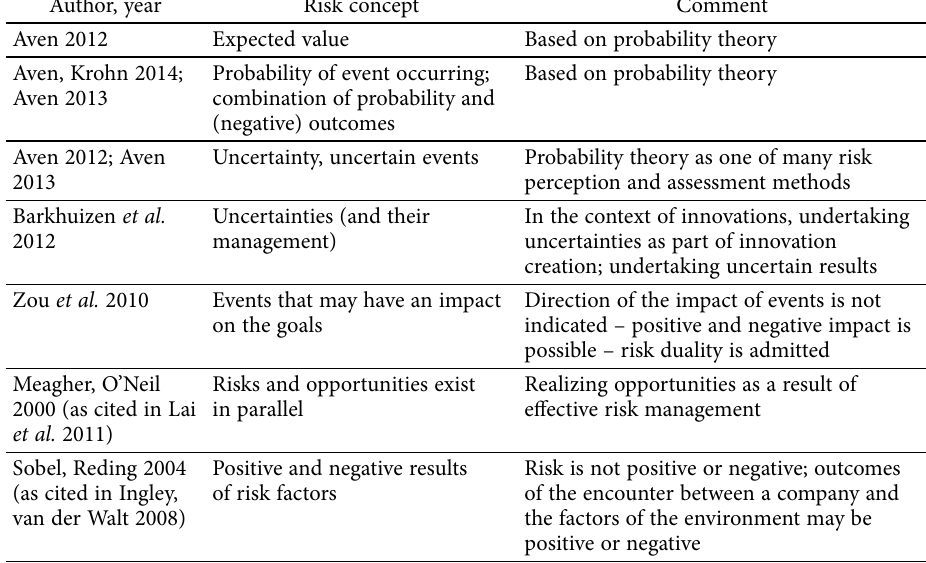
Table 1. Comparison of different risk